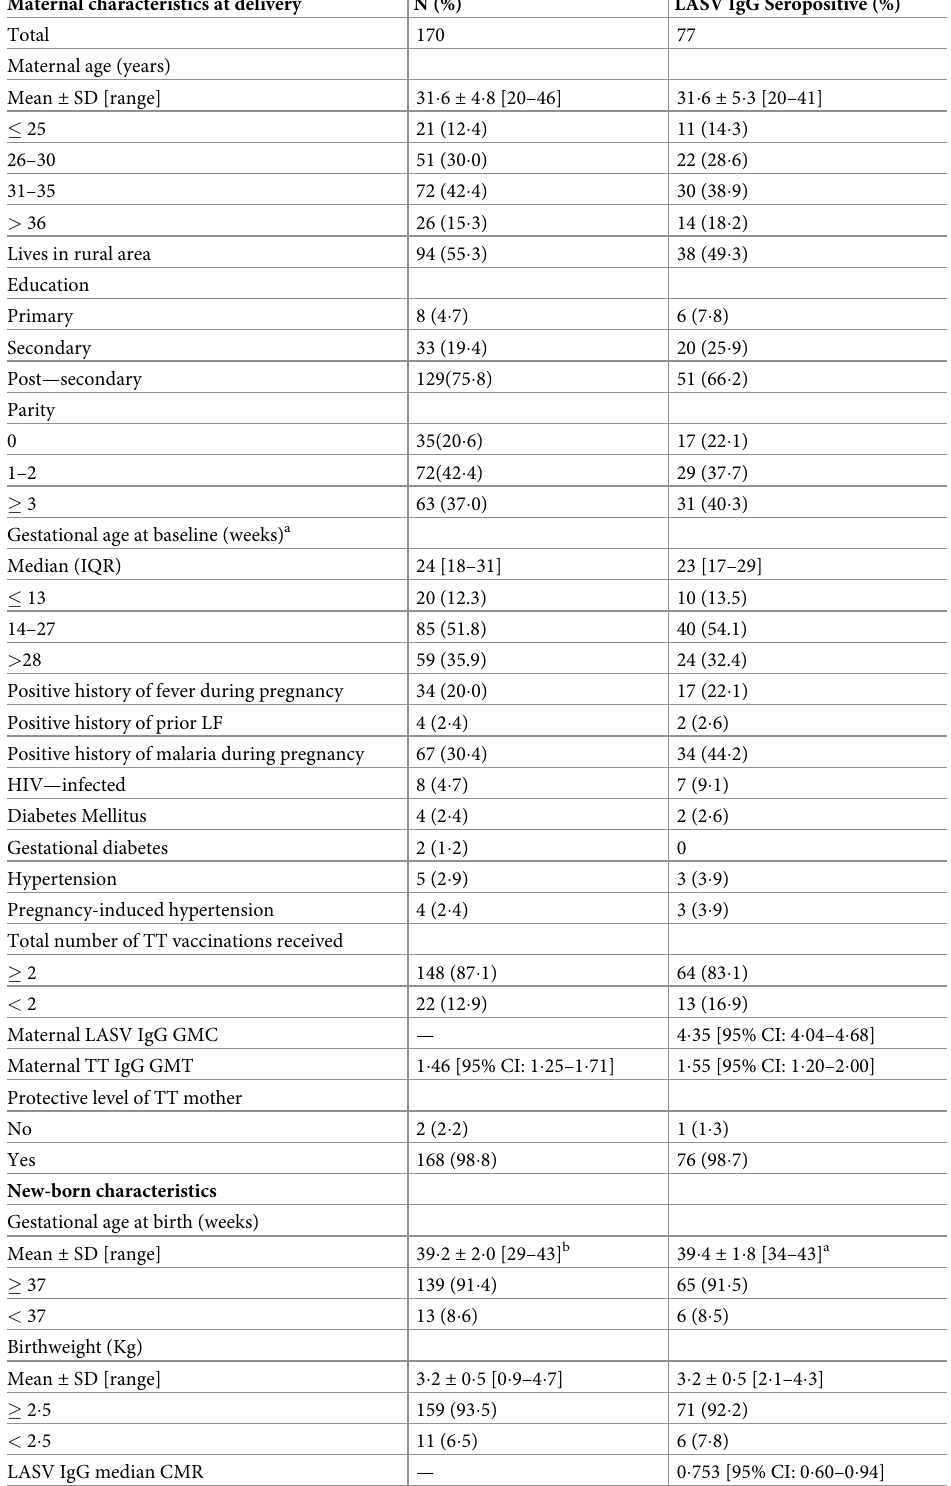
Table 1. General characteristics of mothers-child